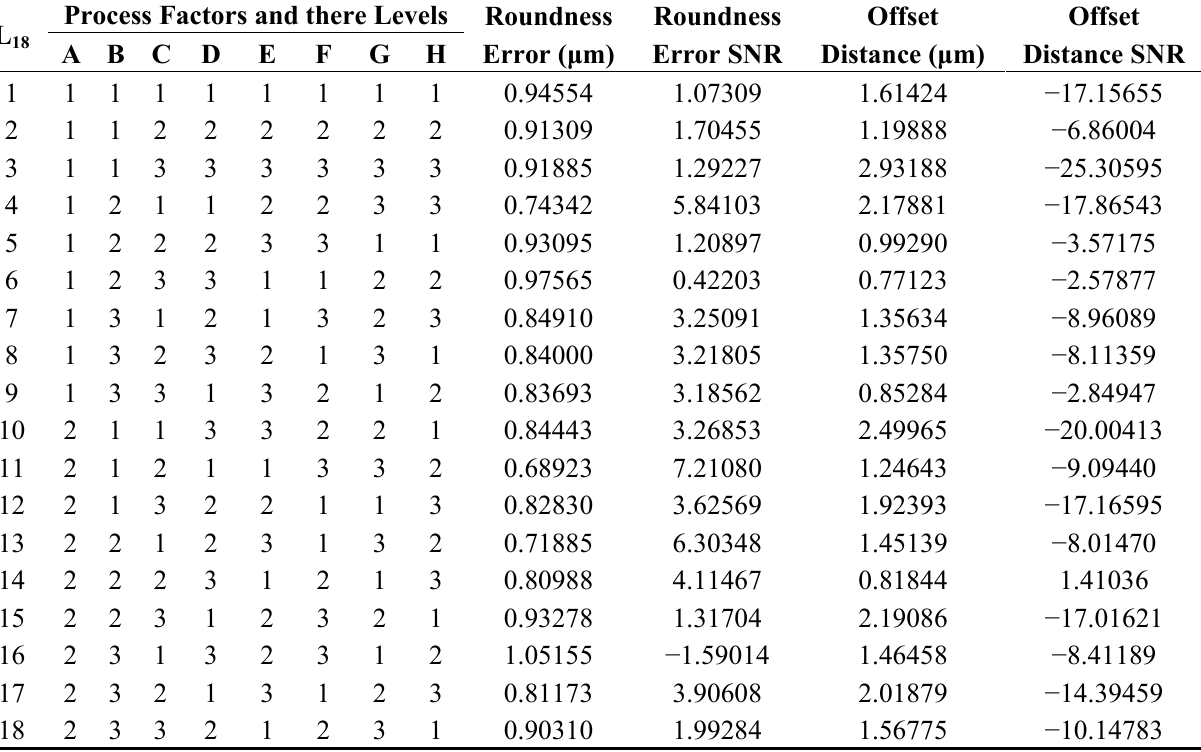
Table 2. L (2 1 × 3 7 ) orthogonal 18